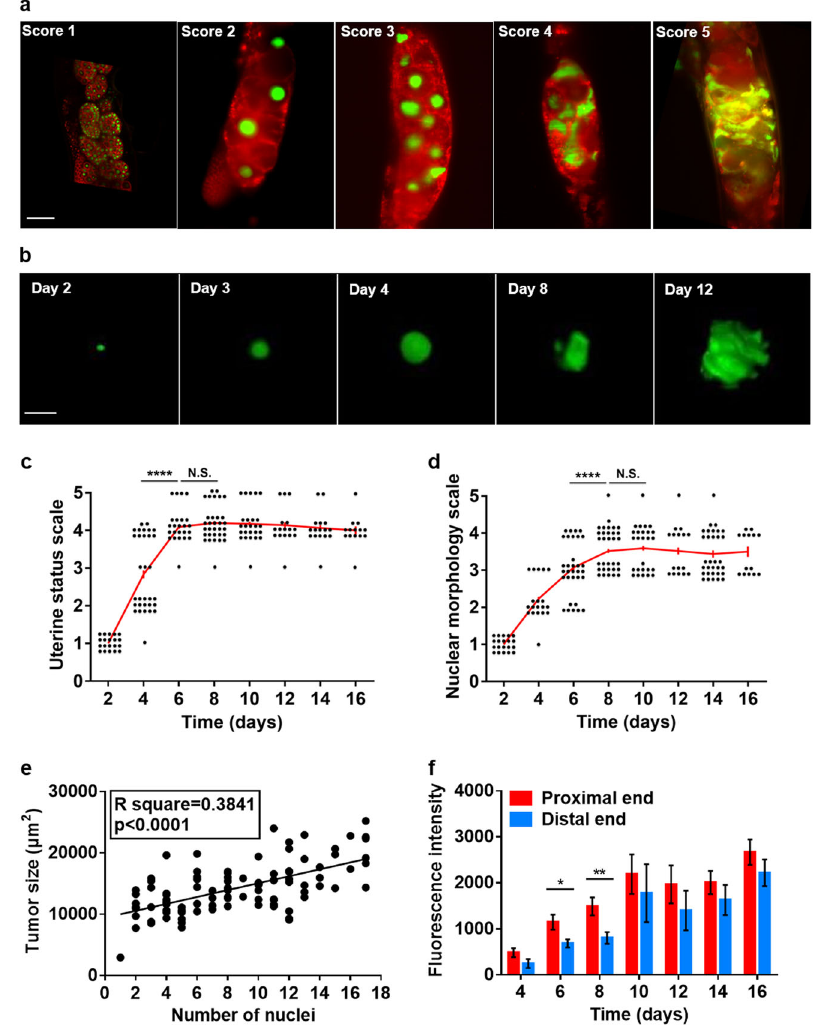
Uterine status scale: class 1, normal uterus containing eggs (day 1 adult). Class 2, slightly abnormal uterine contents, but no tumor visible. Class 3, small tumor. Class 4, medium sized tumor. Class 5, large tumor, fi lling body cavity and squashing the intestine. d Changes in nuclear morphology during tumor aging. Nuclear morphology scale (predominant morphology in tumor): class 1, normal sized, spherical nuclei. Class 2: moderately enlarged, spherical nuclei. Class 3: very large nuclei becoming non-spherical. Class 4: very large nuclei with frequent